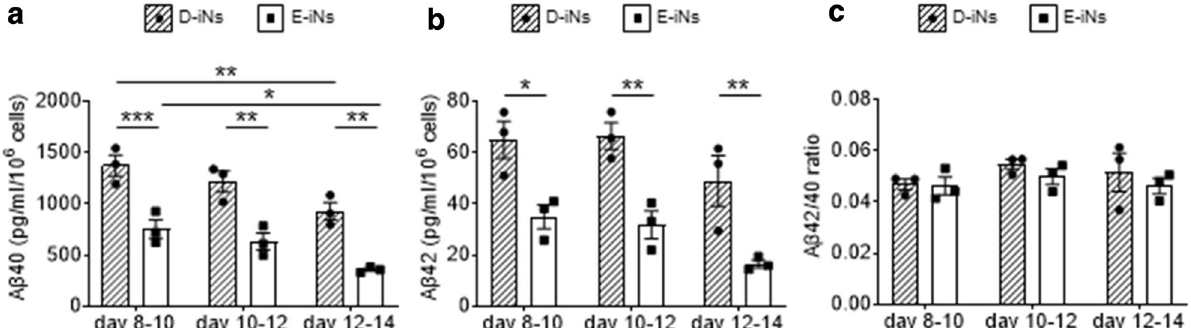
Figure 3. Aβ secretion from iNs at different periods. (a,b) Amount of secreted Aβ40 (a) and Aβ42 (b) from iNs at the indicated periods. ( c) The Aβ40/Aβ42 ratio at each period. ELISA results obtained from technical duplicates and biological triplicates are shown. Data are means ± SEM; ***, p < 0.001; **, p < 0.01; *, p < 0.05; two-way ANOVA test followed by Bonferroni’s multiple comparison test (a,b) . Two-way ANOVA found no significance (interaction p value = 0.8188) in (c) .